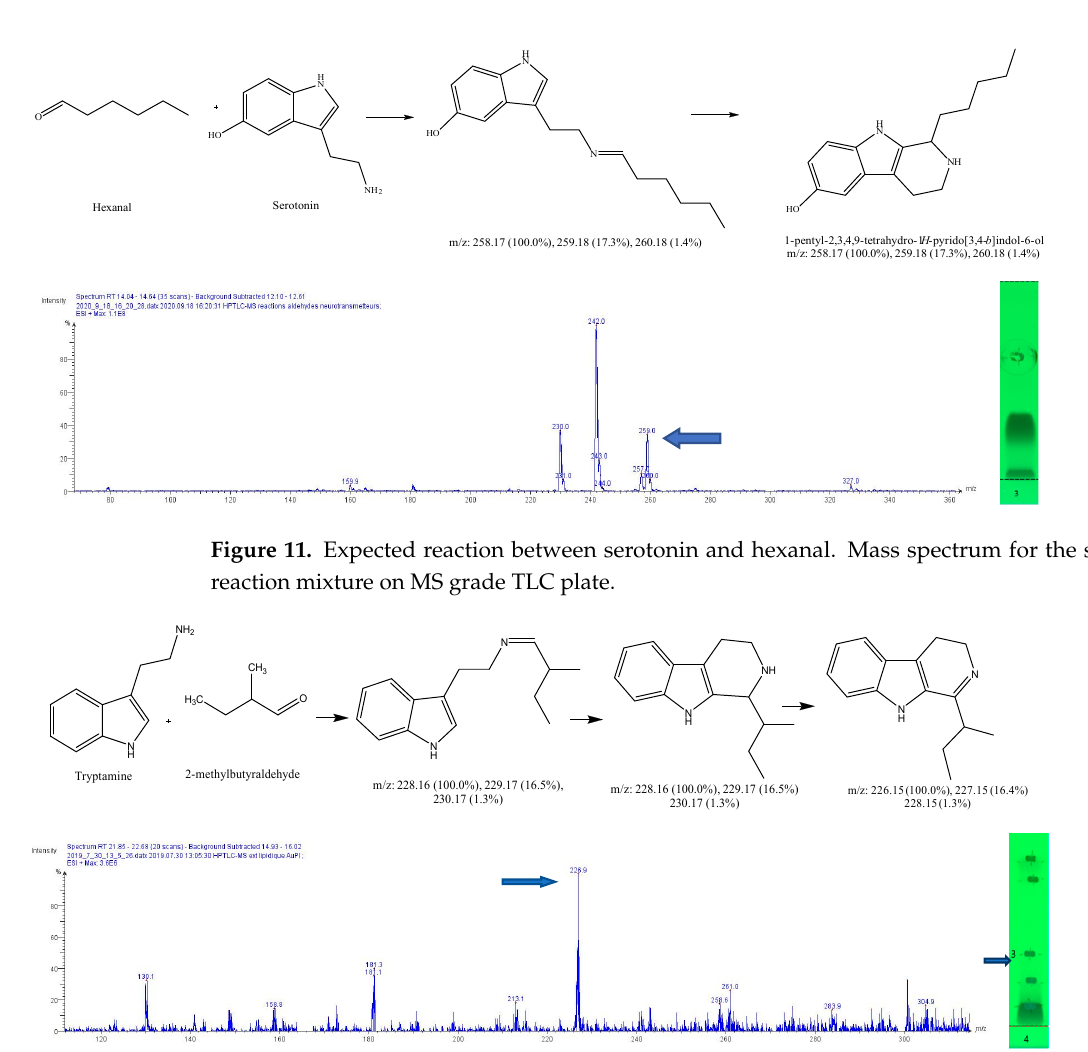
Figure 12. Expected reaction between 2-methylbutyraldehyde and tryptamine. Mass spectrum for the 3rd spot of the reaction mixture on MS grade TLC plate.